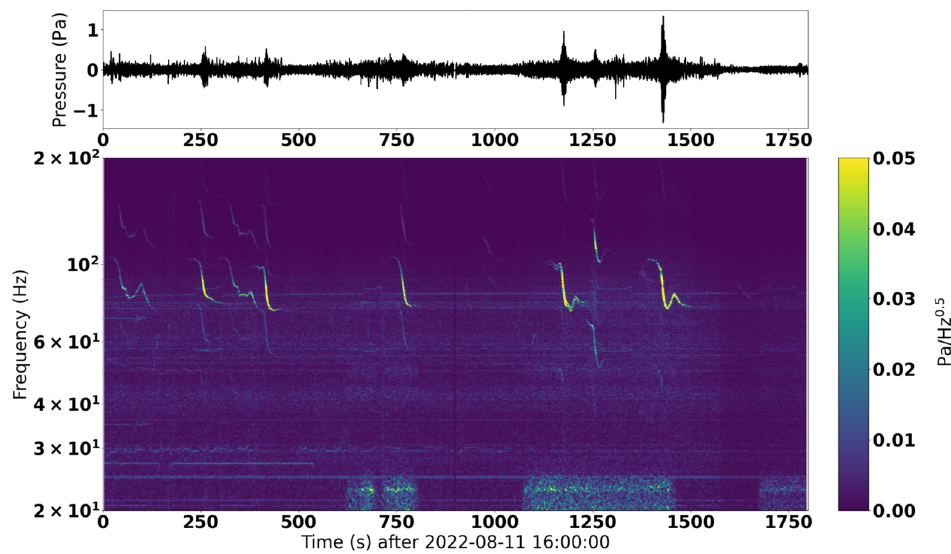
Figure 10. ( top ) Time trace and ( bottom ) spectrogram of OSU1 data during confirmed flyovers by multiple airplanes on 11 August 2022. Time is measured relative to 16:00 UTC on 11 August 2022.